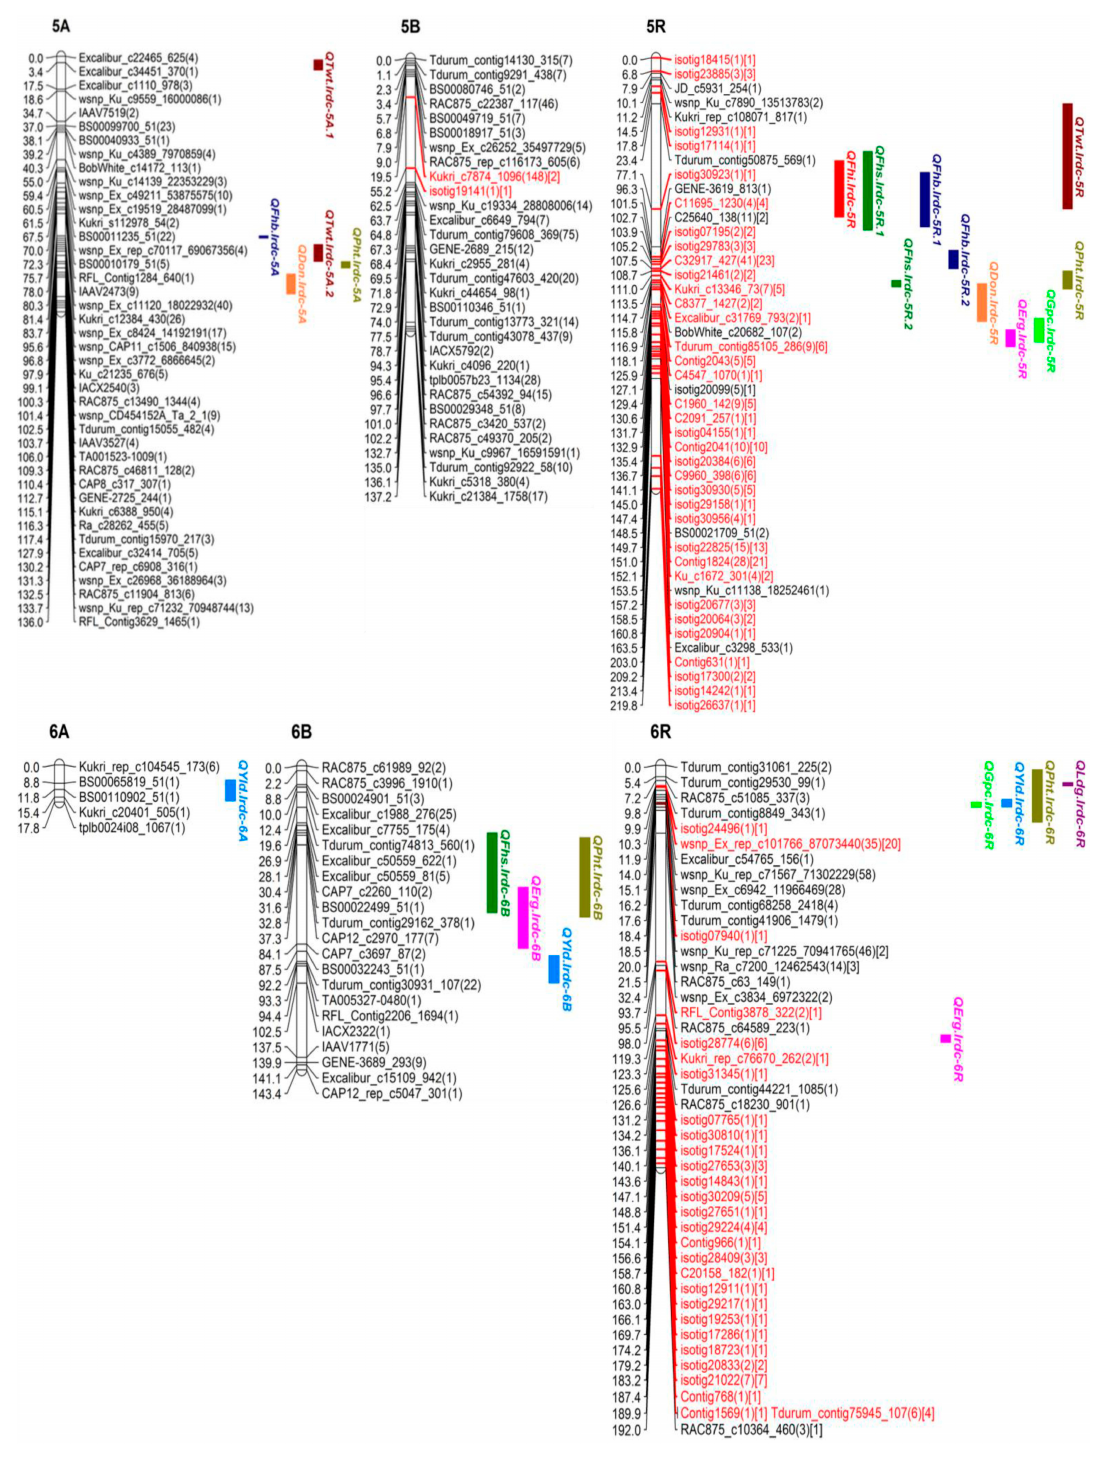
Figure 6. Homoeologous groups 5 and 6 SNP map of TMP16315/AC Ultima triticale DH population. Loci on chromosome maps are represented by unique markers. Marker names in black and red colors represent genomic regions largely dominated by SNPs derived from wheat genomes A/B/D and rye genome R, respectively. Numbers in round brackets represents total number of SNPs at the locus and number in square brackets represents SNPs derived from R genome. Red colored bar of chr 6R indicates interchanged/translocated fragment from chr 4R. The QTL for different traits are given on the right side of maps.